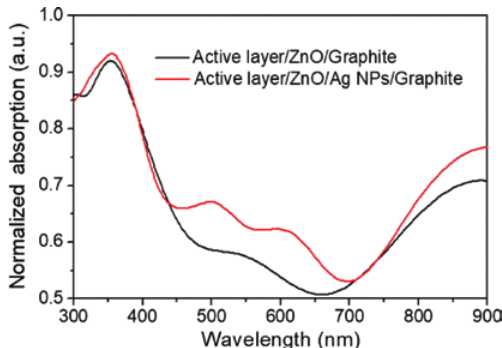
Figure 4: Simulated optical absorption calculated in the active layer for devices A and C.